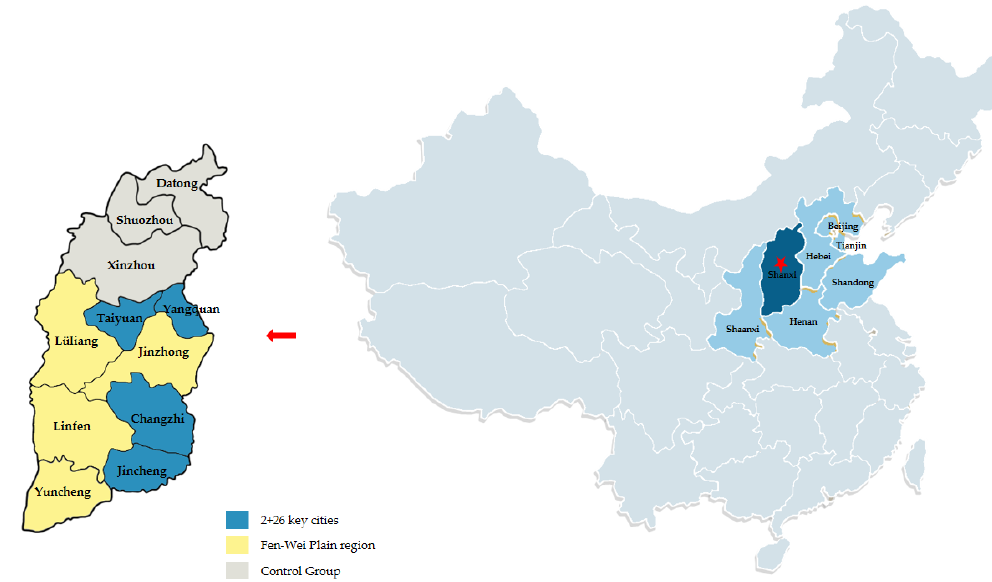
Figure 2. Shanxi province and its three